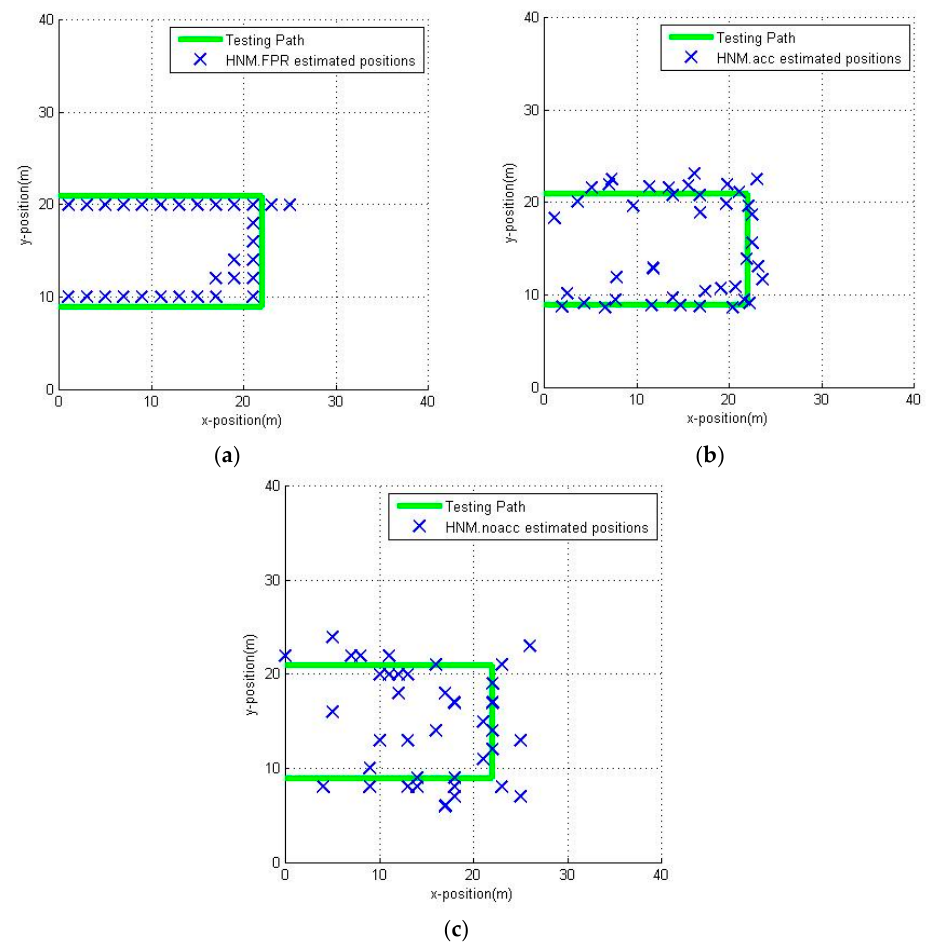
Figure 14. Estimated positions by different positioning methods: ( a ) HMM.FPR; ( b ) HMM.acc; ( c ) HMM.noacc. ( c )